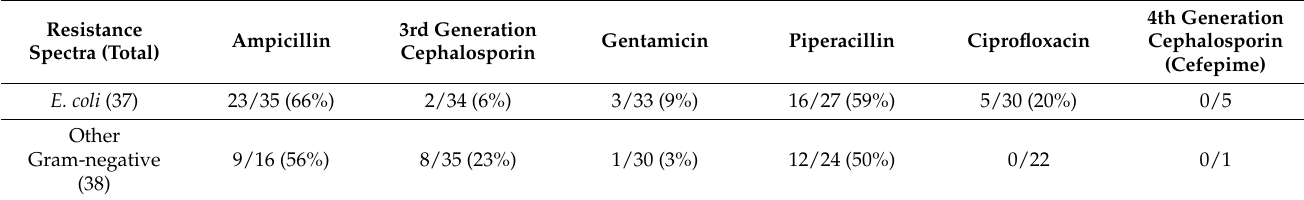
Table 4. Gram-negative bacterial antimicrobial